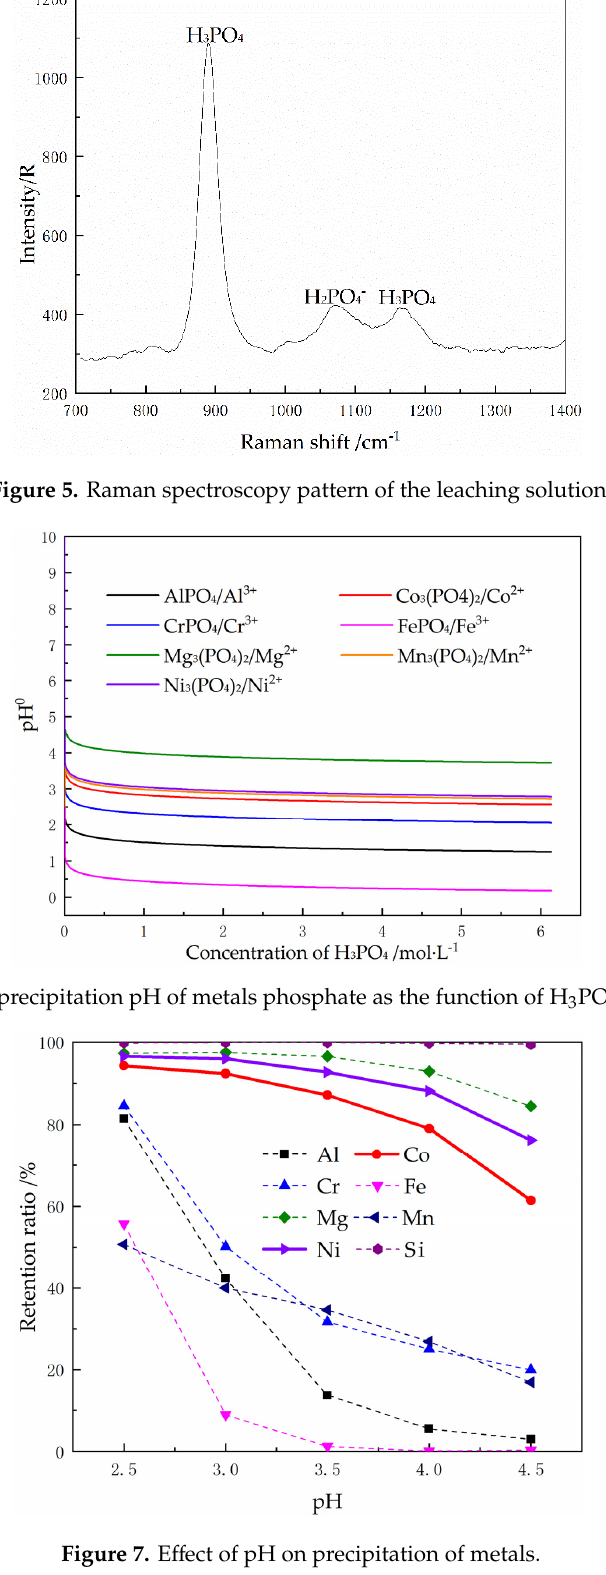
Figure 8. Effect of pH on the extraction of metals with P204. Using P507 as Extractant